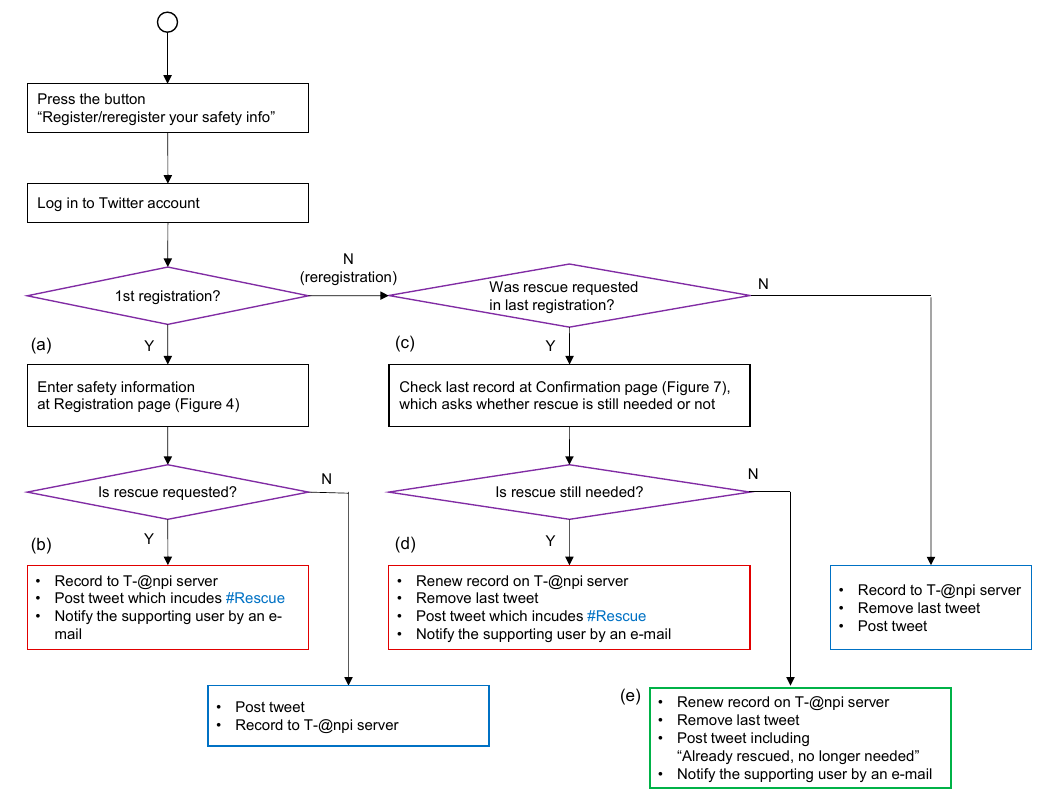
Figure 3. Flow of registering and reregistering the safety information.